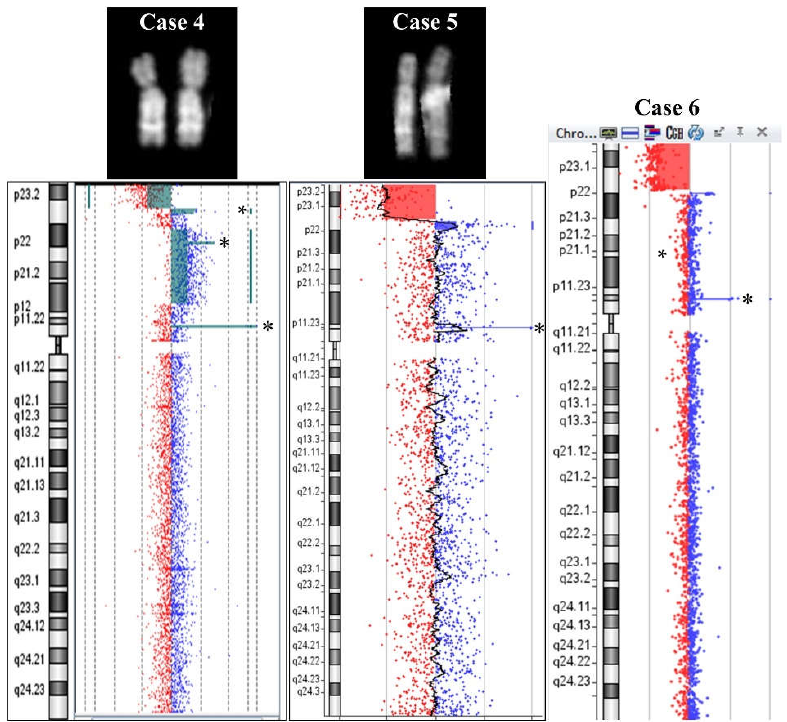
Figure 3. Cases 4, 5, and 6. QFQ-banded chromosomes for case 4 ( left ) and 5 ( middle ). Array CGH ideograms for case 4, 5, and 6 (from left to right ). Asterisks (*) show benign CNVs. Case 5: prenatal diagnosis in a fetus that later died.